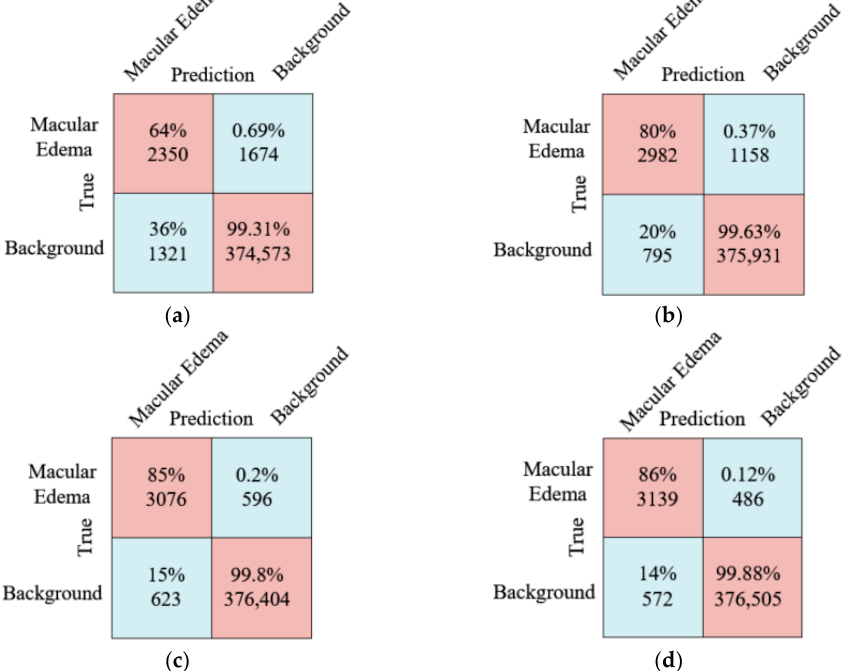
Figure 8. Confusion matrix comparison diagram: ( a ) FCN; ( b ) TransUNet; ( c ) Res-UNet++; ( d ) The proposed method.